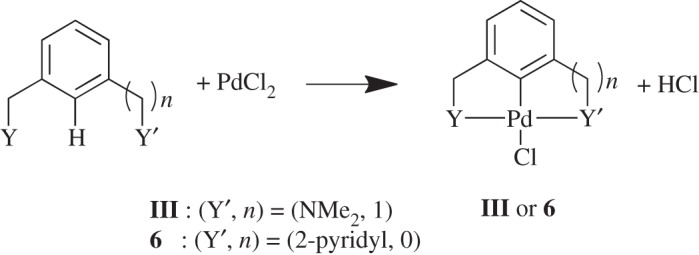
Model formation reaction, where Y = SMe, to unsymmetrical palladacycles III (n = 1, Y′ = NMe2) and 6 (n = 0, Y′ = pyridyl).